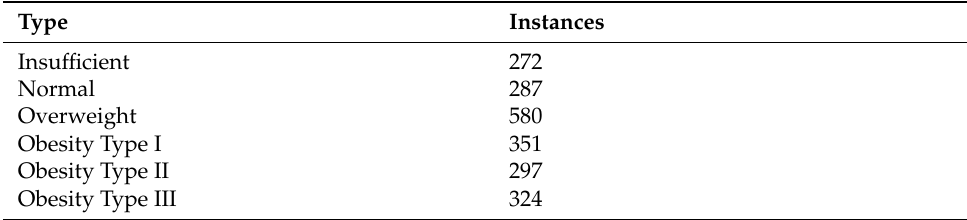
Table 3. Dataset